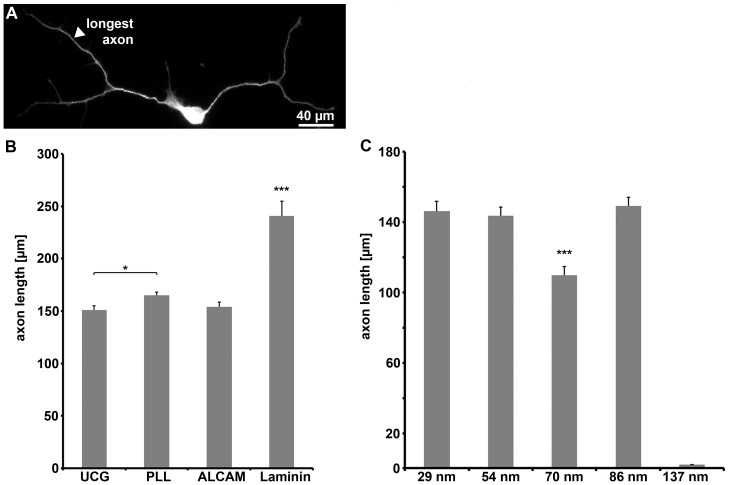
Axon length on various substrates.(A) Immunofluorescence labeling shows a neuron (identified by β3 tubulin staining) with two branched axons. (B) Quantification of length of the longest axon of a neuron (minimal length: 30 µm) on uncoated glass (UCG: n = 280) and glass coated with various substrate molecules (PLL: n = 833; ALCAM: n = 272; laminin: n = 104) or (C) various ALCAM nanopatterns (29 nm: n = 168; 54 nm: n = 463; 70 nm: n = 265; 86 nm: n = 402). As no differences in axon length on uncoated glass and glass coated with 50 µg/ml ALCAM were observed, axon lengths on glass coated with various ALCAM concentrations were not quantified.